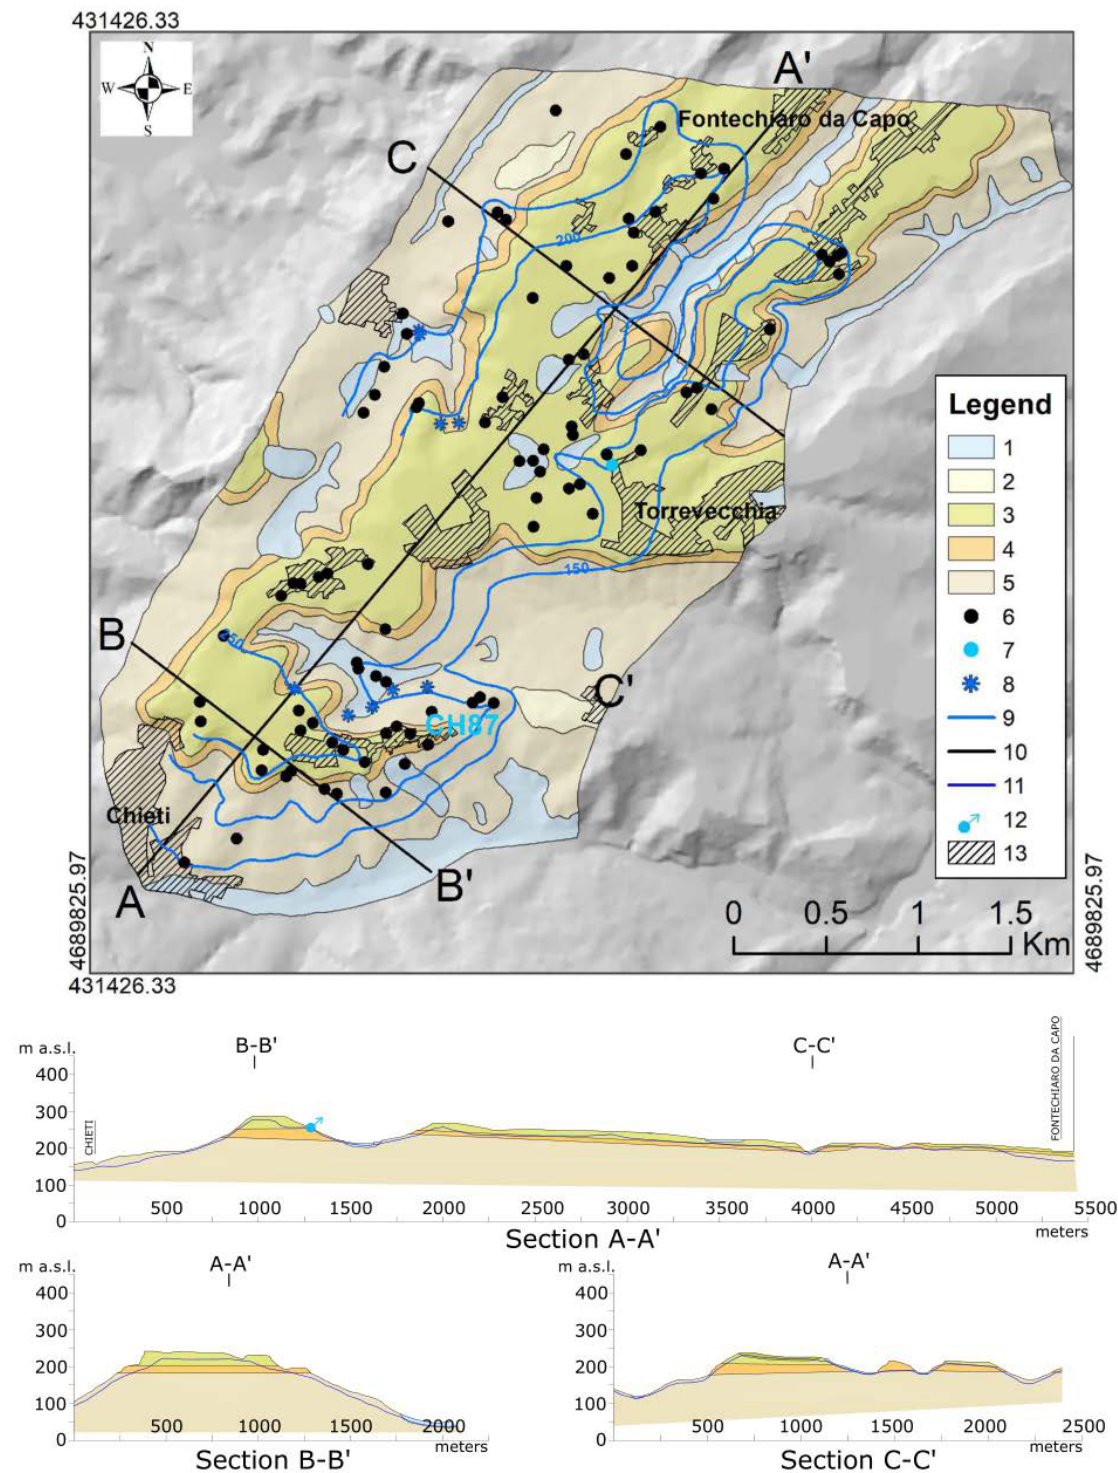
Figure 5. Geological map and cross-sections of the CH area. (1): Recent alluvial and slope deposits (Holocene); (2): Alluvial deposits (Middle Pleistocene-Holocene); (3): Sandy-gravelly deposits (Middle-Upper Pleistocene); (4): Sandy-clayey deposits (Lower Pleistocene); (5): Marly-clayey deposits (Middle-Upper Pliocene); (6): Sampling well; (7): Pumping test well; (8): Spring; (9): Winter water table contour (m a.s.l.); (10): Cross-section trace; (11): Water table (in cross-section); (12): Spring (in cross-section); (13): Urban